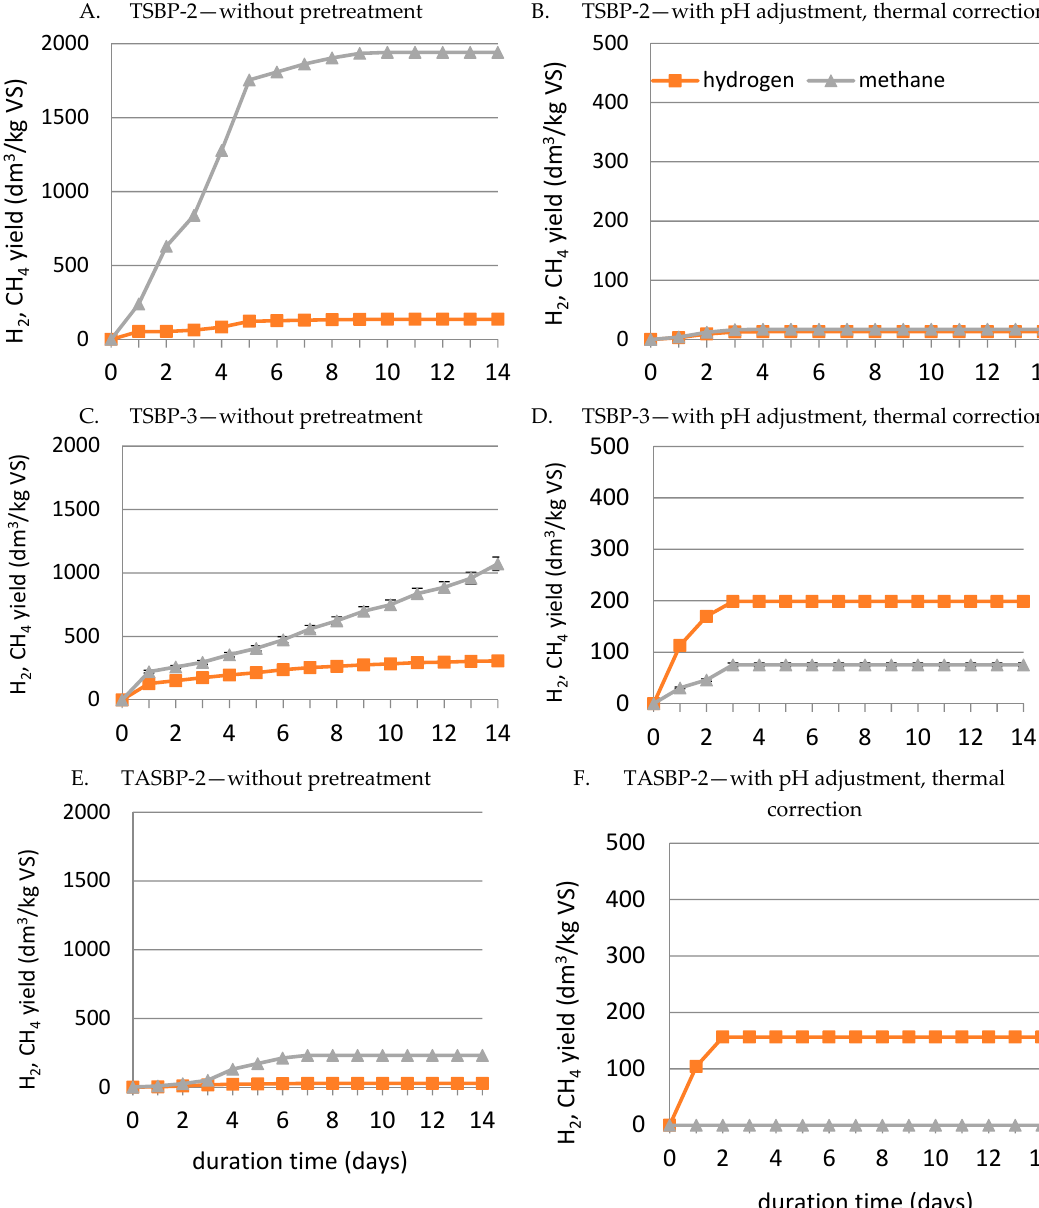
Figure A1. Cumulative hydrogen and methane production without pretreatment ( A —TSBP-2, C —TSBP-3, E —TASBP-2) and with pH adjustment, thermal correction ( B —TSBP-2, D —TSBP-3, F —TASBP-2).